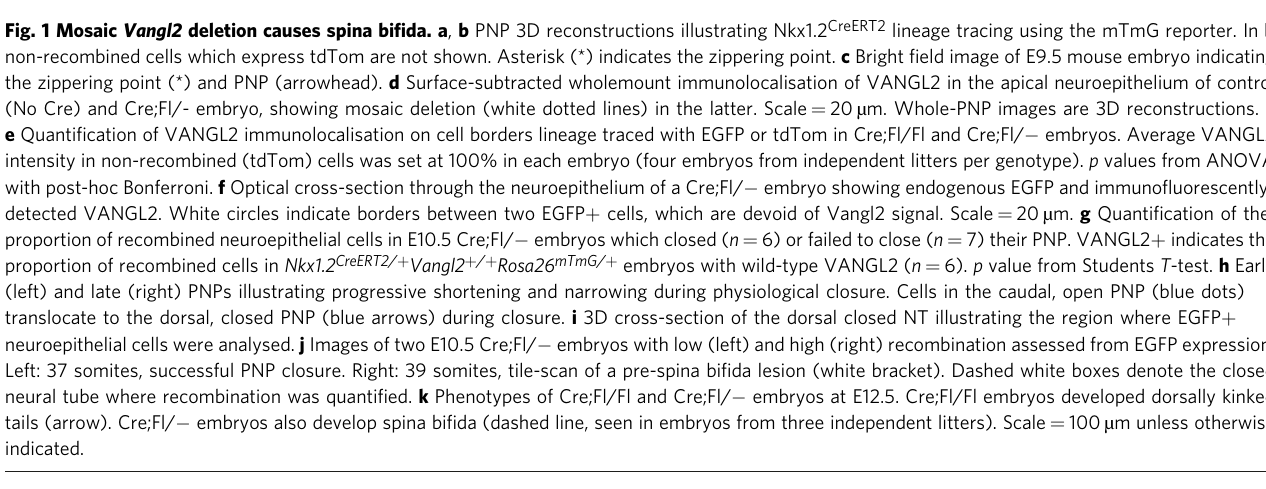
Fig. 1 Mosaic Vangl2 deletion causes spina bi fi da. a , b PNP 3D reconstructions illustrating Nkx1.2 CreERT2 lineage tracing using the mTmG reporter. In b non-recombined cells which express tdTom are not shown. Asterisk (*) indicates the zippering point. c Bright fi eld image of E9.5 mouse embryo indicating the zippering point (*) and PNP (arrowhead). d Surface-subtracted wholemount immunolocalisation of VANGL2 in the apical neuroepithelium of control (No Cre) and Cre;Fl/- embryo, showing mosaic deletion (white dotted lines) in the latter. Scale = 20 µ m. Whole-PNP images are 3D reconstructions. e Quanti fi cation of VANGL2 immunolocalisation on cell borders lineage traced with EGFP or tdTom in Cre;Fl/Fl and Cre;Fl/ − embryos. Average VANGL2 intensity in non-recombined (tdTom) cells was set at 100% in each embryo (four embryos from independent litters per genotype). p values from ANOVA with post-hoc Bonferroni. f Optical cross-section through the neuroepithelium of a Cre;Fl/ − embryo showing endogenous EGFP and immuno fl uorescently- detected VANGL2. White circles indicate borders between two EGFP + cells, which are devoid of Vangl2 signal. Scale = 20 µ m. g Quanti fi cation of the proportion of recombined neuroepithelial cells in E10.5 Cre;Fl/ − embryos which closed ( n = 6) or failed to close ( n = 7) their PNP. VANGL2 + indicates the proportion of recombined cells in Nkx1.2 CreERT2/ + Vangl2 + / + Rosa26 mTmG/ + embryos with wild-type VANGL2 ( n = 6). p value from Students T -test. h Early (left) and late (right) PNPs illustrating progressive shortening and narrowing during physiological closure. Cells in the caudal, open PNP (blue dots) translocate to the dorsal, closed PNP (blue arrows) during closure. i 3D cross-section of the dorsal closed NT illustrating the region where EGFP + neuroepithelial cells were analysed. j Images of two E10.5 Cre;Fl/ − embryos with low (left) and high (right) recombination assessed from EGFP expression. Left: 37 somites, successful PNP closure. Right: 39 somites, tile-scan of a pre-spina bi fi da lesion (white bracket). Dashed white boxes denote the closed neural tube where recombination was quanti fi ed. k Phenotypes of Cre;Fl/Fl and Cre;Fl/ − embryos at E12.5. Cre;Fl/Fl embryos developed dorsally kinked tails (arrow). Cre;Fl/ − embryos also develop spina bi fi da (dashed line, seen in embryos from three independent litters). Scale = 100 µ m unless